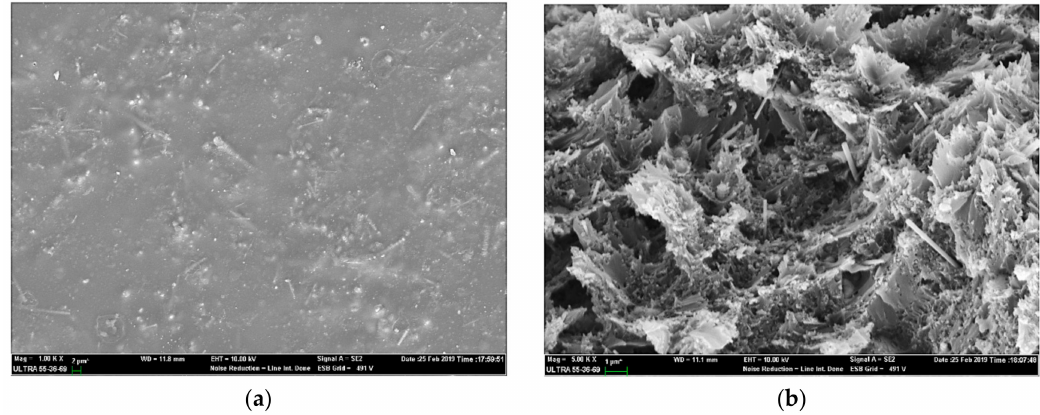
Figure 5. The surface ( a ) and cross sectional ( b ) scanning electron microscopy (SEM) images of the composite